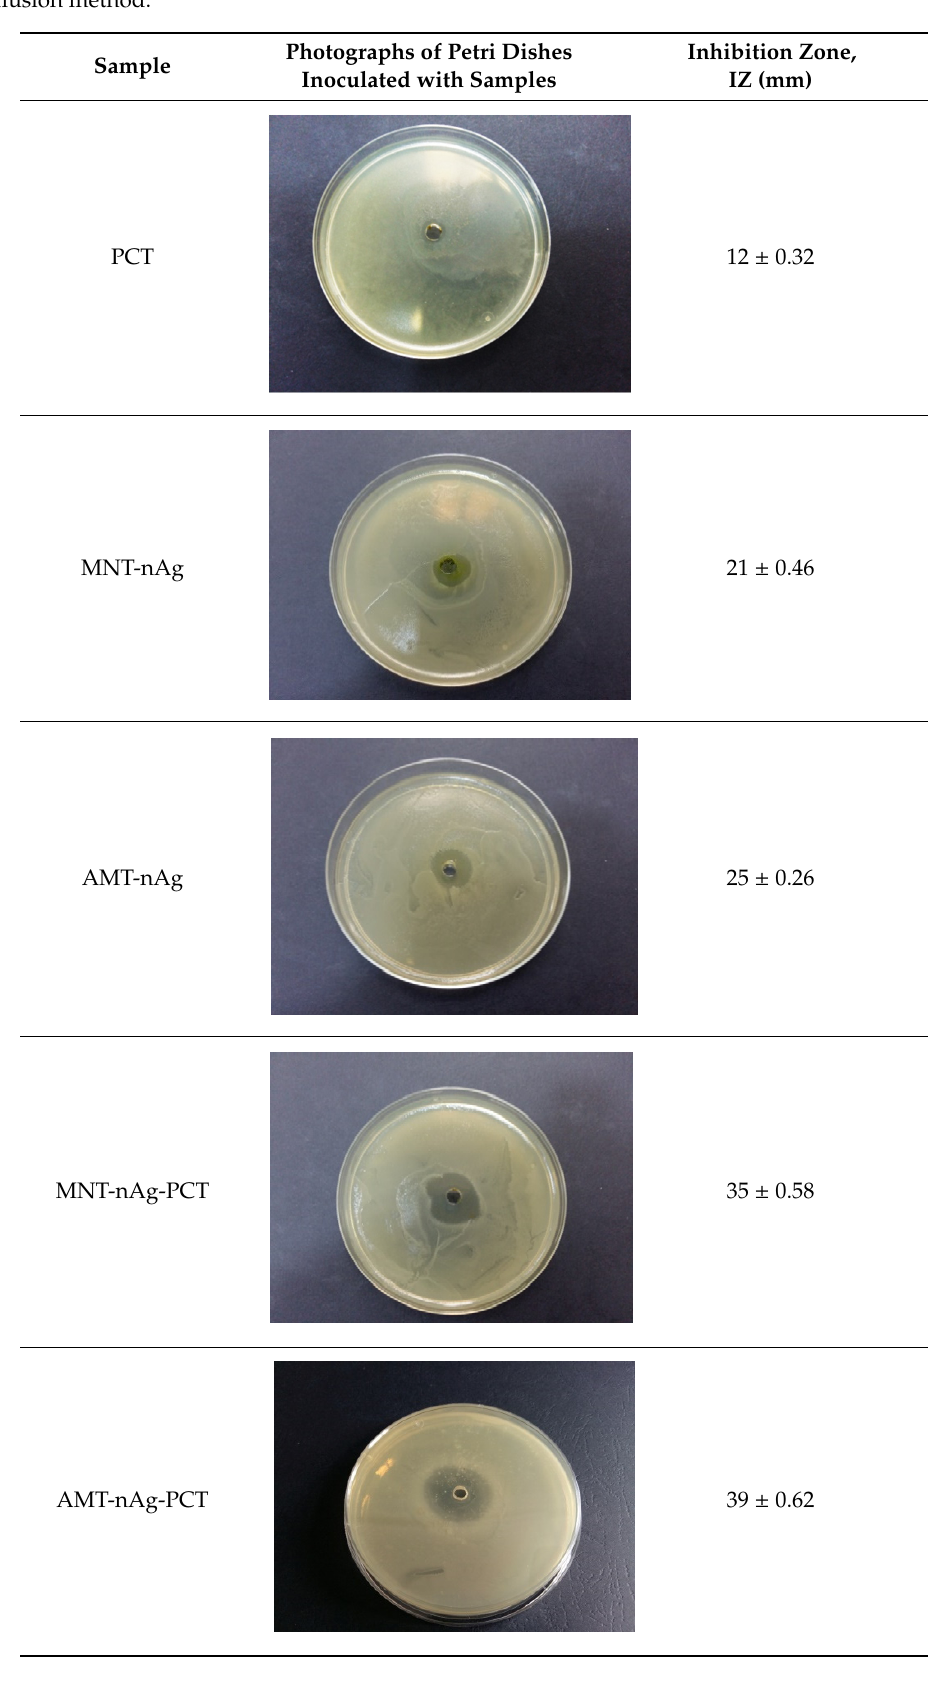
Table 5. Antibacterial activity (against Escherichia coli ) of the prepared samples, estimated by agar well di ff usion